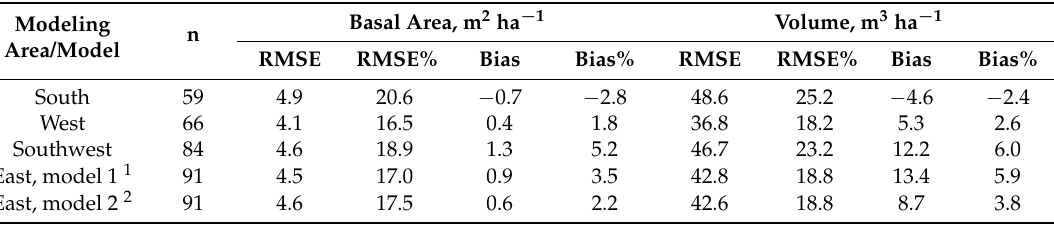
Table 5. Summary of plot-level validation results in the mixed coniferous forest class. RMSE = root mean square error, RMSE% = error relative to mean value of plots, n = number of plots used in validation.